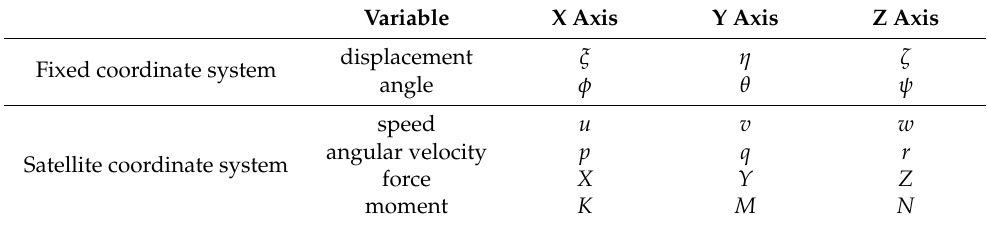
Table 1. Parameters of Kinematic Model of Underwater Vehicle.